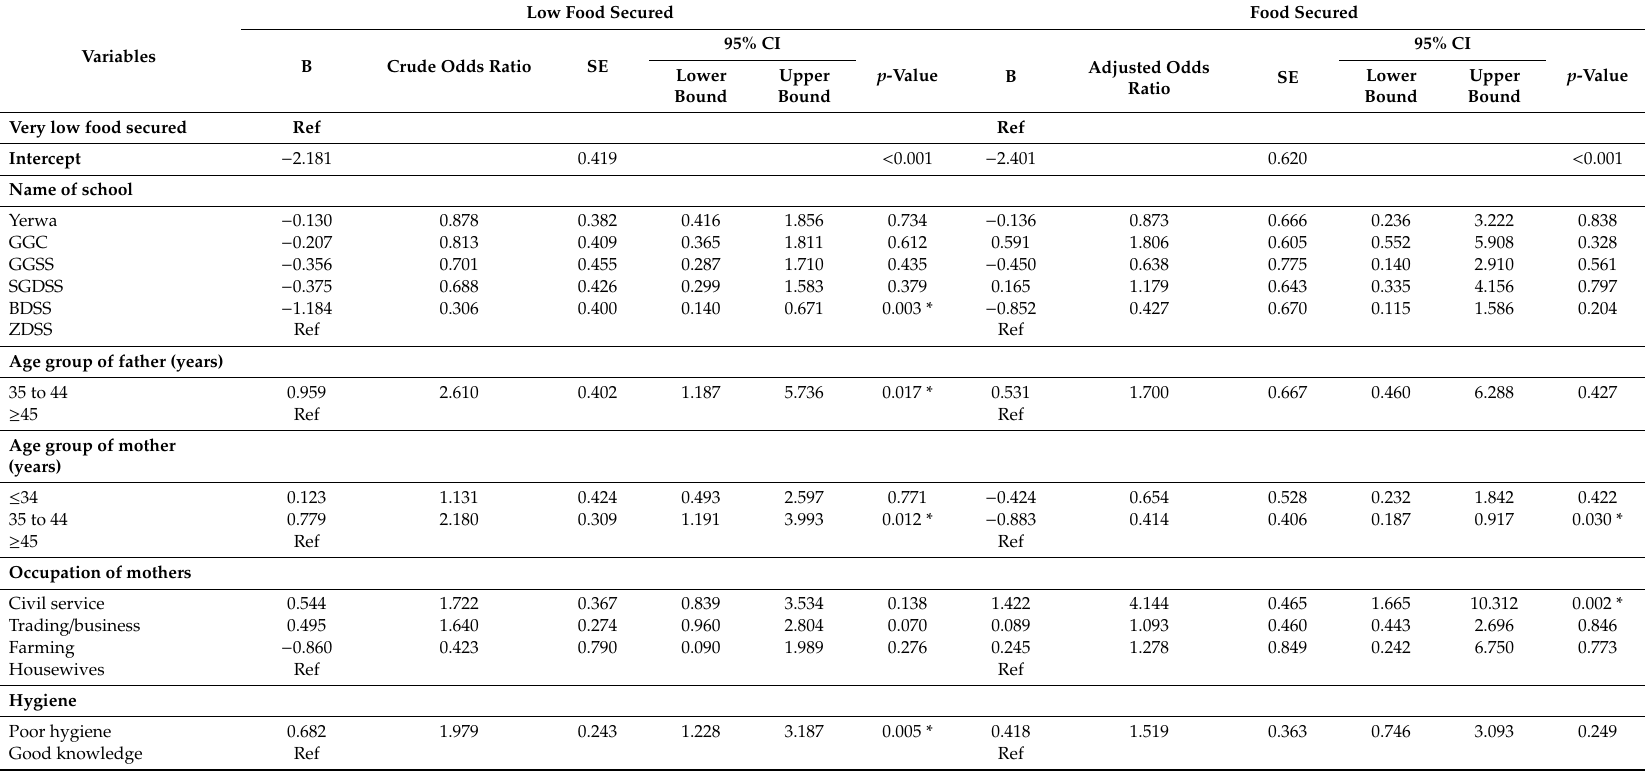
Table 4. Multinomial logistic regression for predictors of food